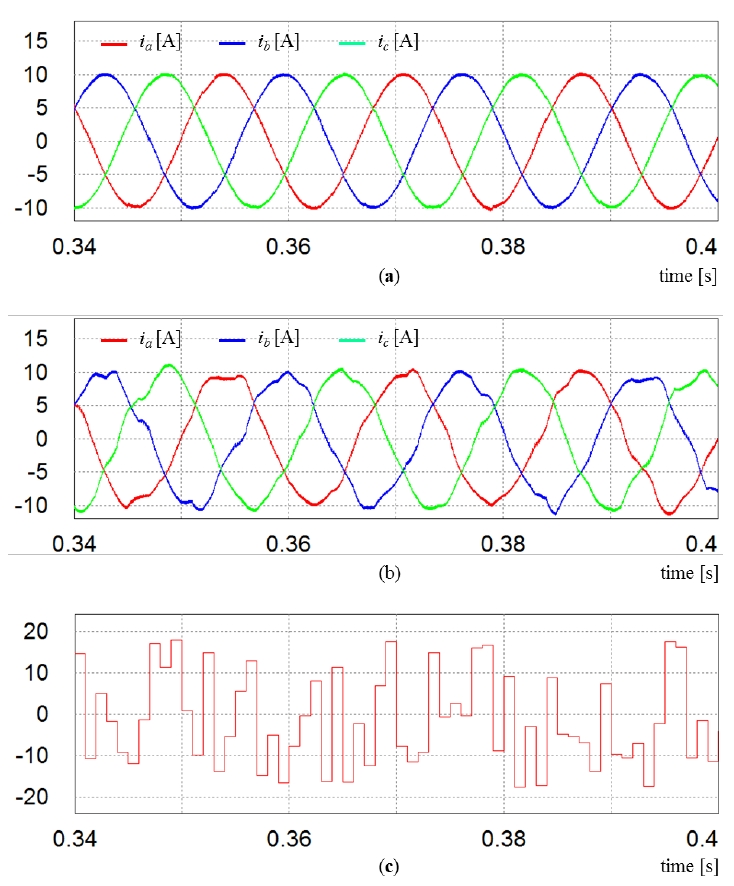
Figure 14. Steady-state current responses with random limited-band disturbances: ( a ) using the proposed control scheme; ( b ) using the conventional PI controller; and ( c ) waveform of random disturbances in three-phase grid voltages.